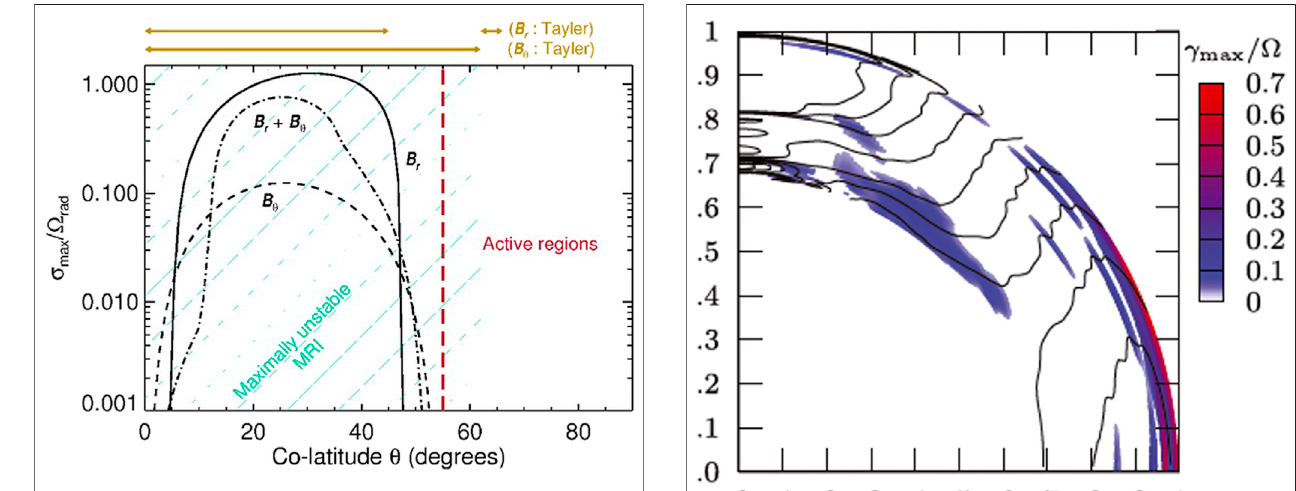
FIGURE 14 | Results of the MRi in the solar tachocline. Growth rate of the fastest growing mode in units of the rotation rate as a function of the co- latitude angle for radial ( B r ; black solid curve), latitudinal ( B θ ; dashed curve), and both radial and latitudinal ( B r + B θ ; dot-dashed curve) magnetic fi elds.Thehatchingindicatesthemaximallyunstableregion, asdetermined by the Balbus stability criterion. The arrows above the plot delimit the areas potentially subject to Tayler instability for radial and latitudinal fi elds. Active regions are found to the right of the vertical long-dashed line. Adapted from Parfrey and Menou (2007). © AAS. Reproduced with permission.